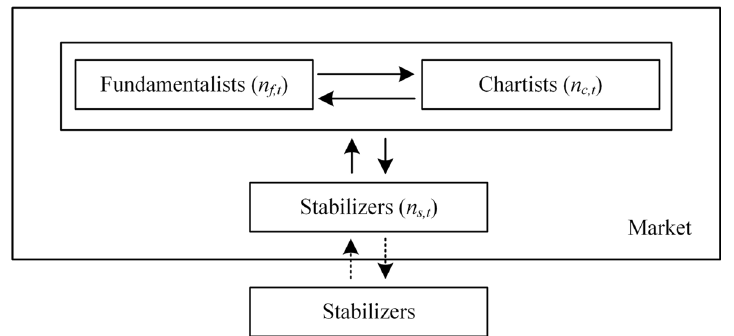
Fig. 1 Switching among fundamentalists, chartists, and stabilizers. Solid arrows indicate switching and dashed arrows indicate entering and leaving the market. As per the discrete choice theory, the most basic switching in the stock market is the interaction between fundamentalists and